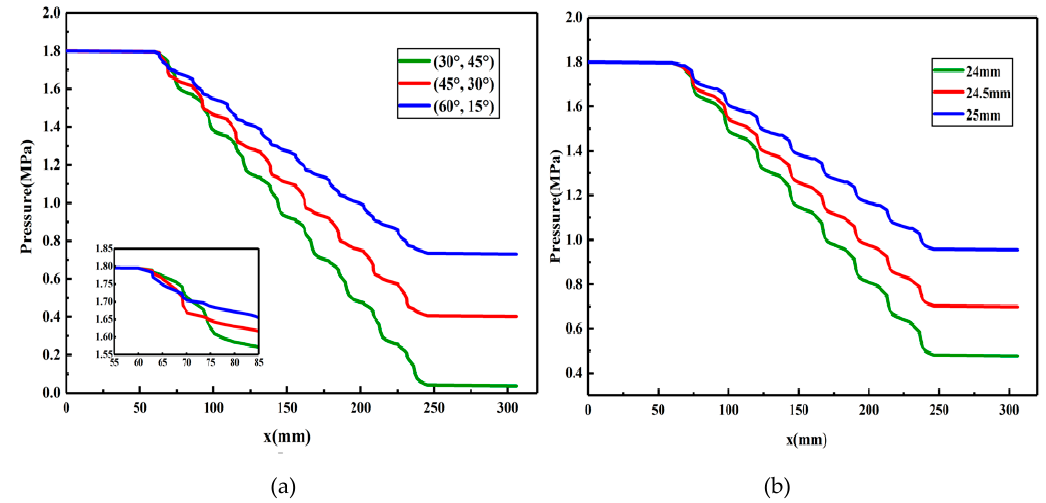
Figure 10. Pressure curve of the polymer solution flowing through partial pressure tools with different structural parameters. ( a ) Front groove angle/rear groove angle. ( b ) Radius of the outer cylinder.